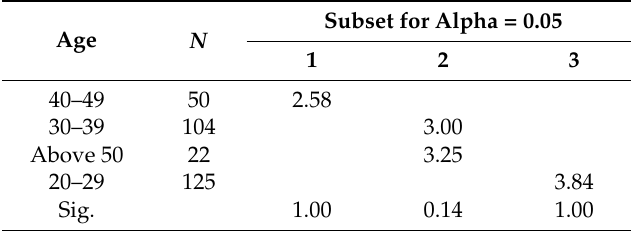
Table 3. Public’s subsidies expectations of different